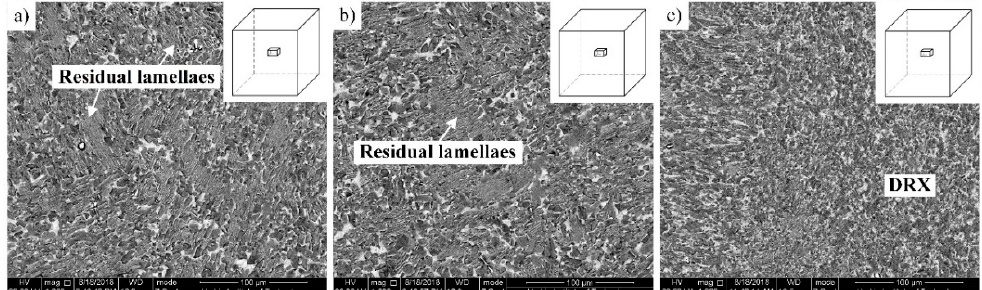
Figure 4. Effect of forging temperature on microstructures of Ti-43Al-2Cr-1.5Mn-0.2Y alloy. ( a ) 1150 °C, ( b ) 1200 °C, ( c ) 1250 °C.